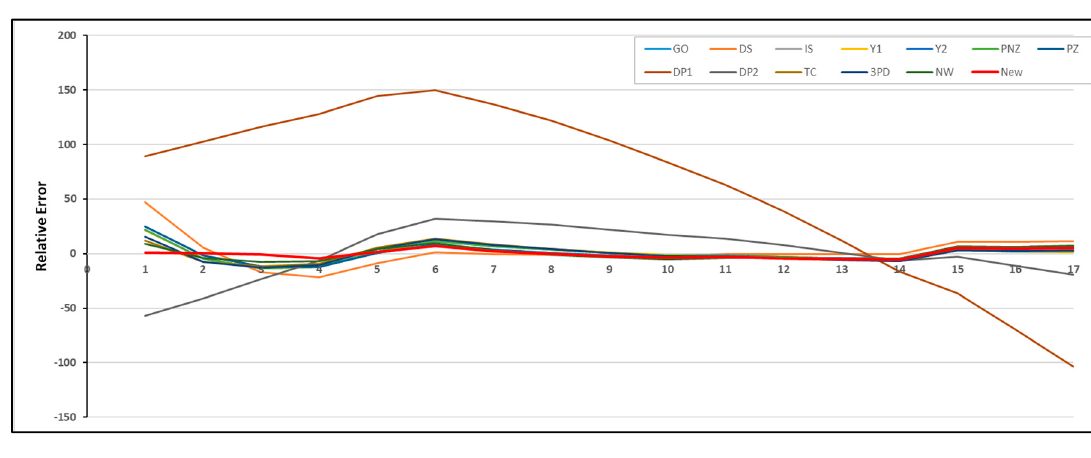
Figure 8. RE curve for Dataset #1.